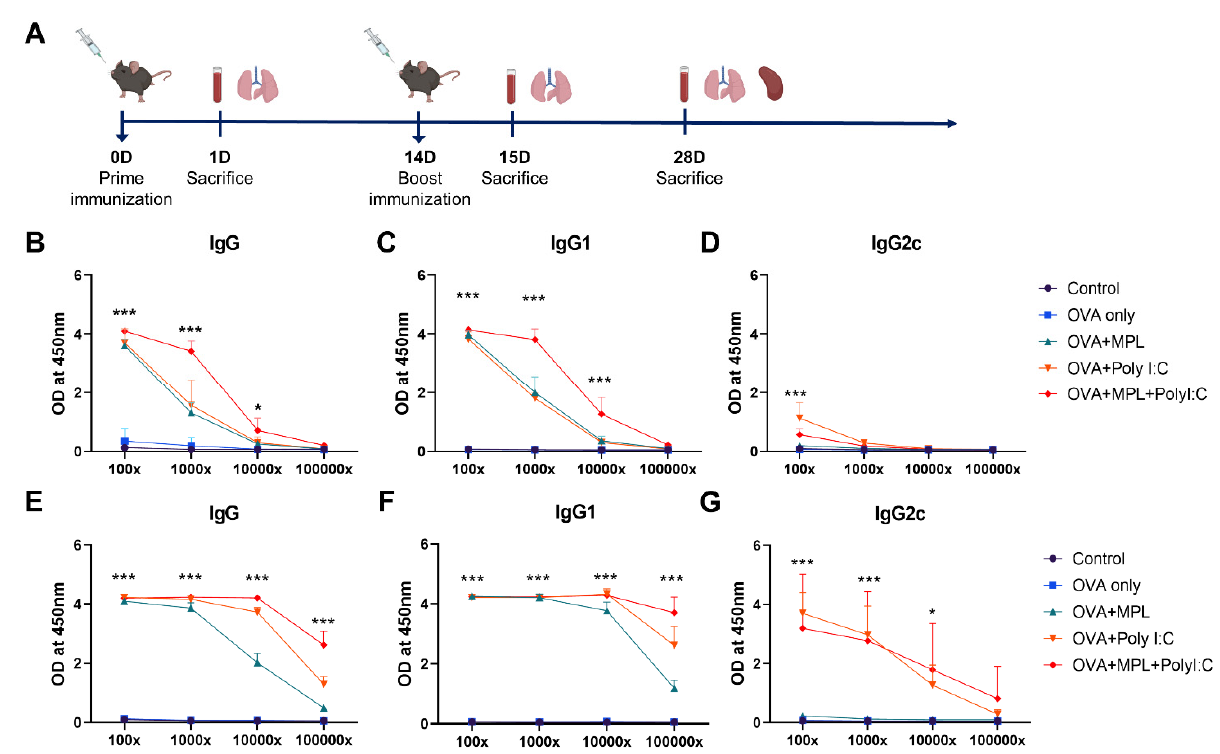
Figure 1. Immunization schedule and sera OVA-specific antibody levels after immunizations. ( A ) A scheme of immunization and sample collection schedule. ( B – G ) OVA-specific antibody levels in the immune sera were measured by ELISA. The sera were taken at 2-weeks after each prime ( B – D ) and boost ( E – G ) immunization. All result were shown in mean ± SEM. For statistical analysis, two-way ANOVA and Tukey’s post-multiple comparison tests were performed. * p < 0.05; and *** p < 0.001 compared with OVA group.